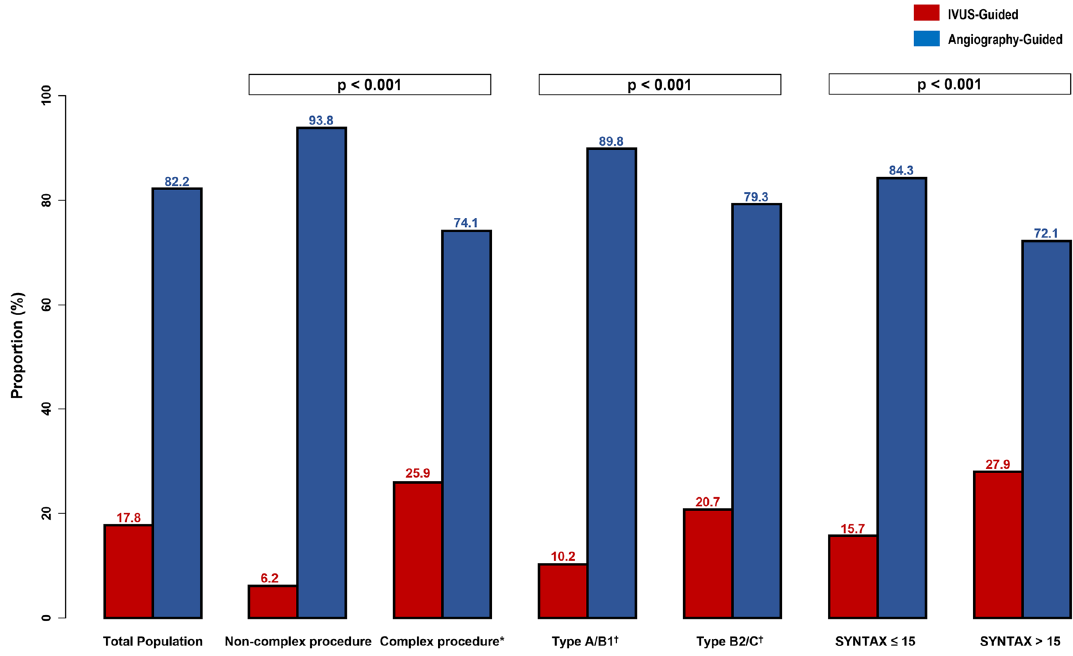
Figure 2. Proportion of IVUS-guided PCI according to lesion complexity. The bar chart shows proportion of IVUS-guided PCI according to lesion complexity. The proportion of IVUS-guided PCI (red bar) versus angiography-guided PCI (blue bar) are shown. *Complex procedure is defined as bifurcation, chronic total occlusion, left main disease, long lesion, multivessel PCI, multiple stent implantation, in-stent restenosis, or heavily calcified lesion. † AHA/ACC lesion classification. IVUS, intravascular ultrasound; PCI, percutaneous coronary intervention; SYNTAX, Synergy between PCI with Taxus and Cardiac Surgery.